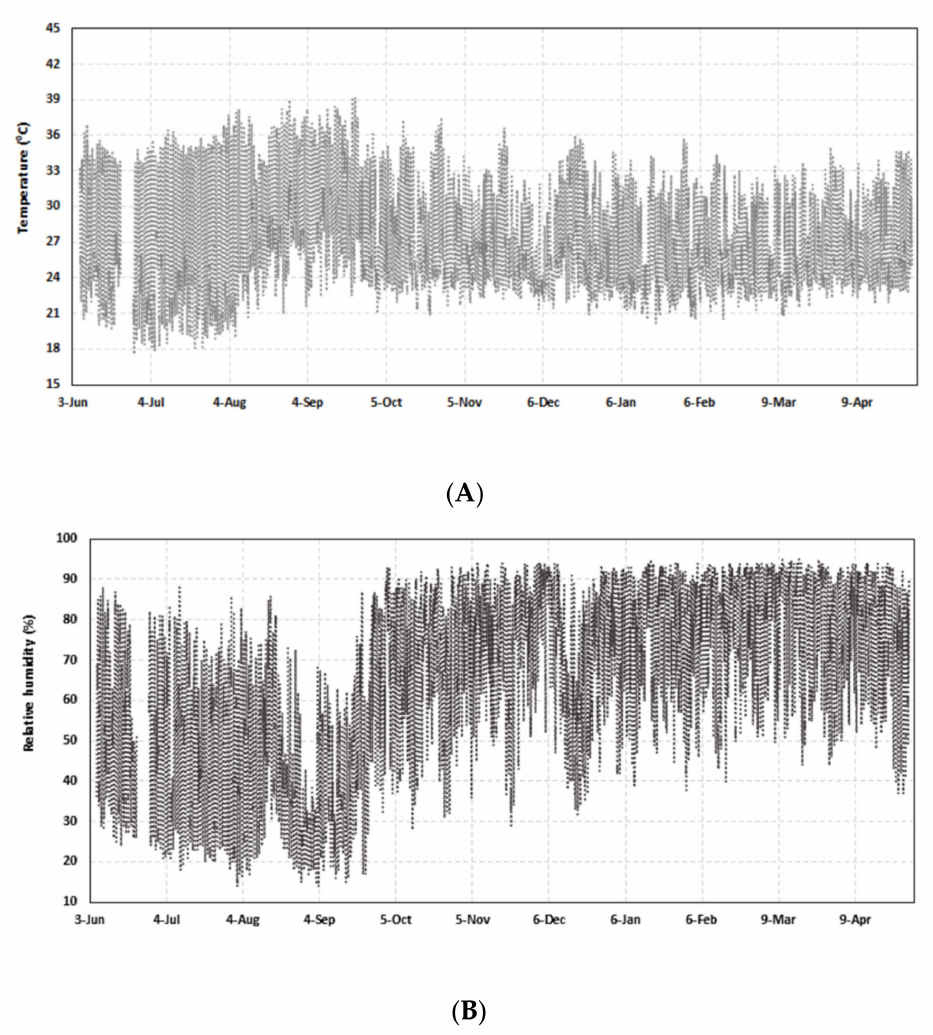
Figure 9. Outdoor climate: ( A ) Temperature; ( B ) Relative Humidity.